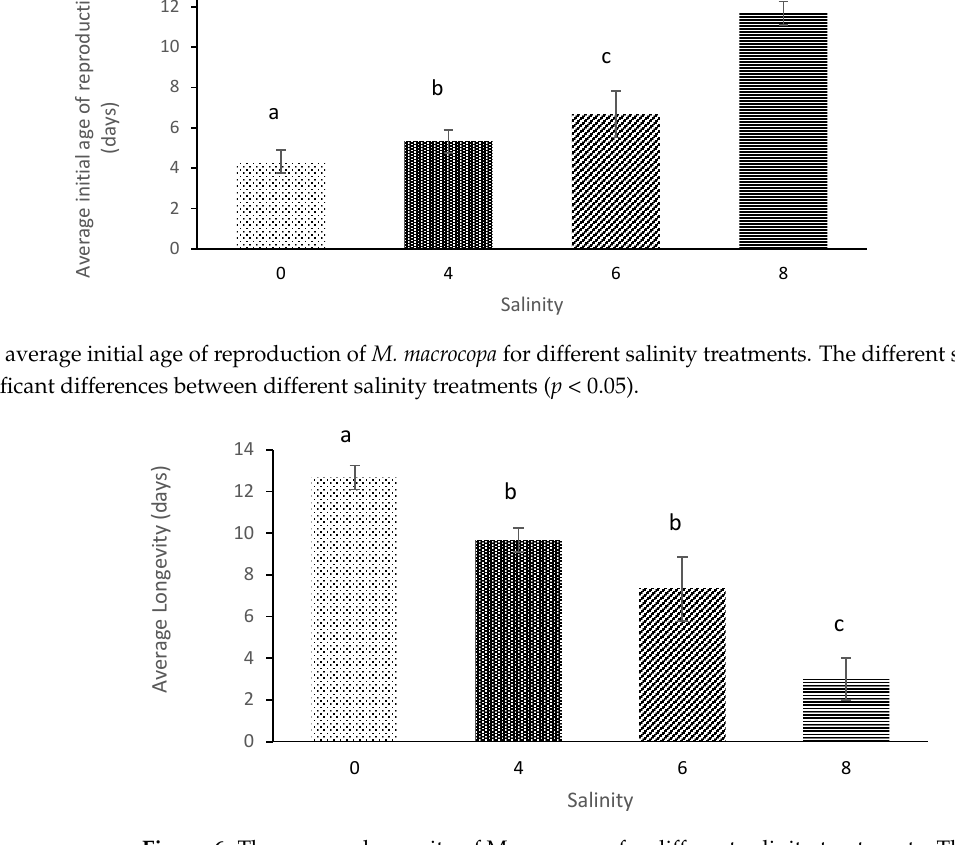
Figure 6. The average longevity of M. macrocopa for different salinity treatments. The different small letters indicate significant differences between different salinity treatments ( p < 0.05).